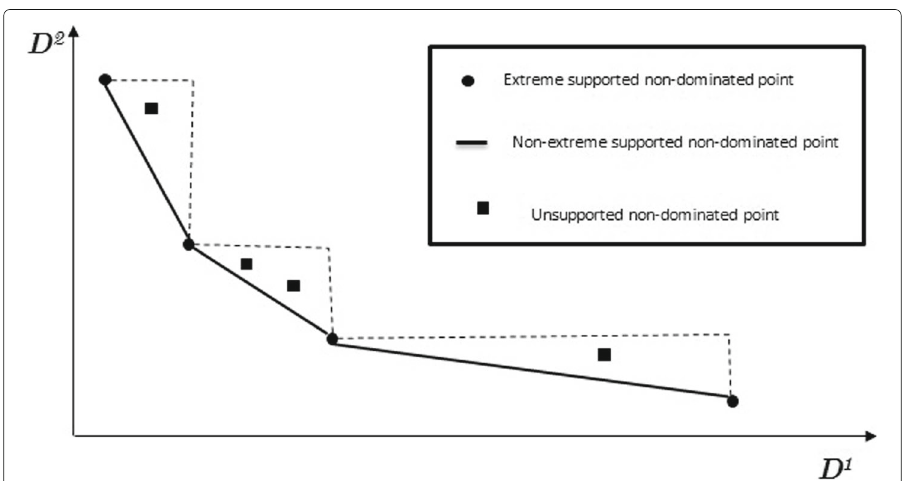
Fig. 1 Classification of the non-dominated